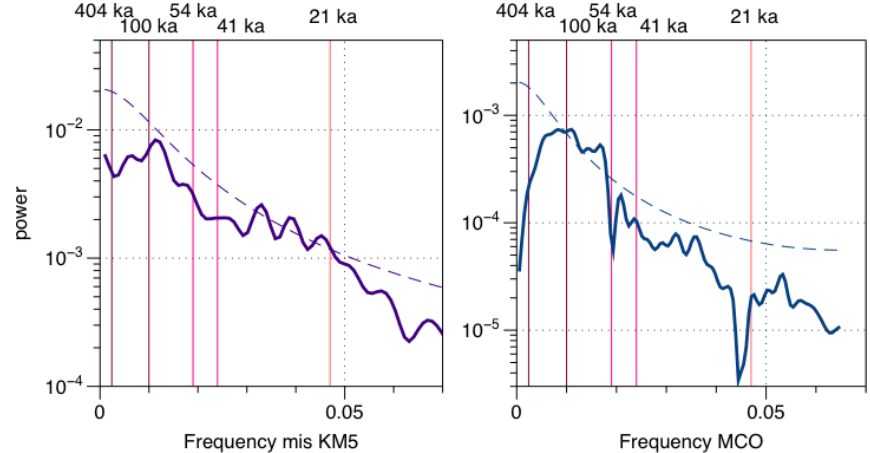
Figure 11. MTM spectral analysis of the CaCO 3 AR record through time (Meyers, 2014; R Core Team, 2021). The dashed lines represent the 95% significance level. The pink shadows correspond to the orbital periodicities (eccentricity at 404 and 100ka, obliquity at 54 and 41ka, and precession at